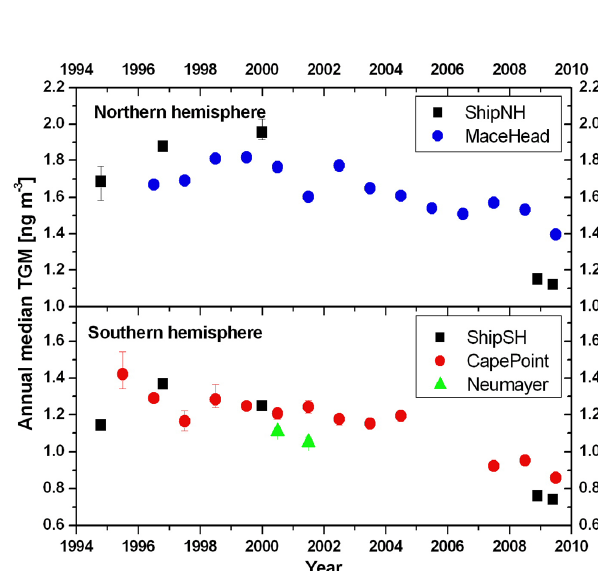
Fig. 1. Trends of GEM concentrations in the Northern and South- ern Hemispheres. The points and bars represent the annual medians and the 95% confidence intervals of the medians, respectively. Mer- cury was measured by manual double amalgamation technique (see text) at Cape Point until 2004 and during the ship cruise in 1994, all other measurements were made automated technique. The an- nual medians of automated TGM measurements at Cape Point were calculated using daily mean concentrations. The annual medians at Mace Head were calculated from baseline hourly mean concentra- tions (Ebinghaus et al., 2010). The median confidence intervals for the continuous measurements are smaller than the